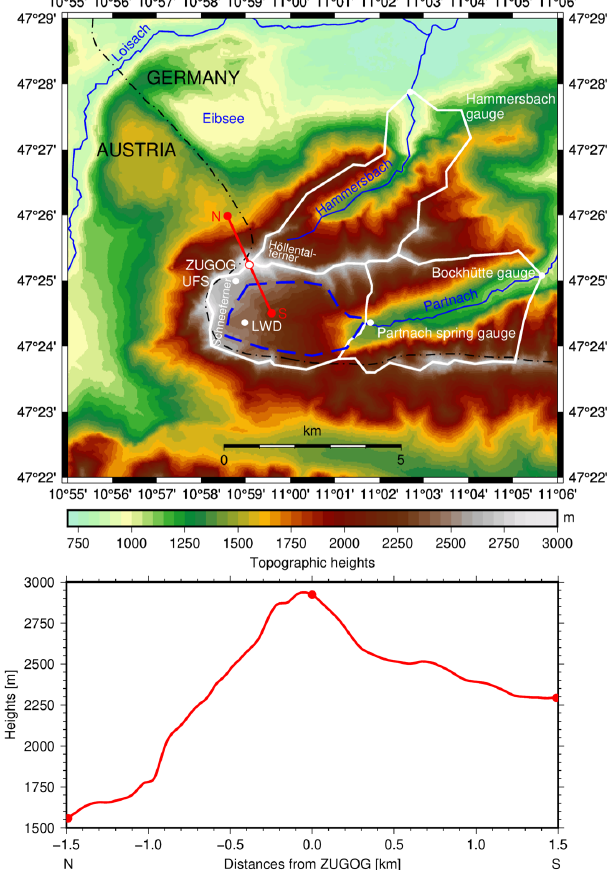
Figure 1. Topographic heights around the Zugspitze Geodynamic Observatory Germany (ZUGOG), the Environmental Research Sta- tion (UFS) and the hydro-meteorological station (LWD), the alpine catchments (white lines) and Partnach spring (11km 2 ) as part of Bockhütte (25km 2 ), with their corresponding gauge stations, and the Hammersbach catchment (14km 2 ), with its planned gauge sta- tion, the estimated groundwater body below Zugspitzplatt (blue dashed line) and a topographic north–south profile through ZUGOG transverse to the maximum slopes (red